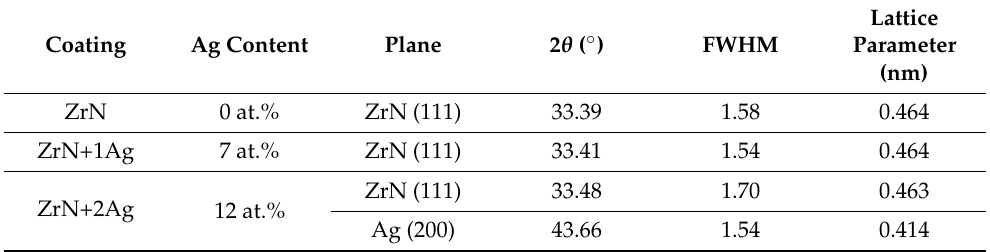
Table 4. The 2 θ and FWHM values obtained from XRD patterns.